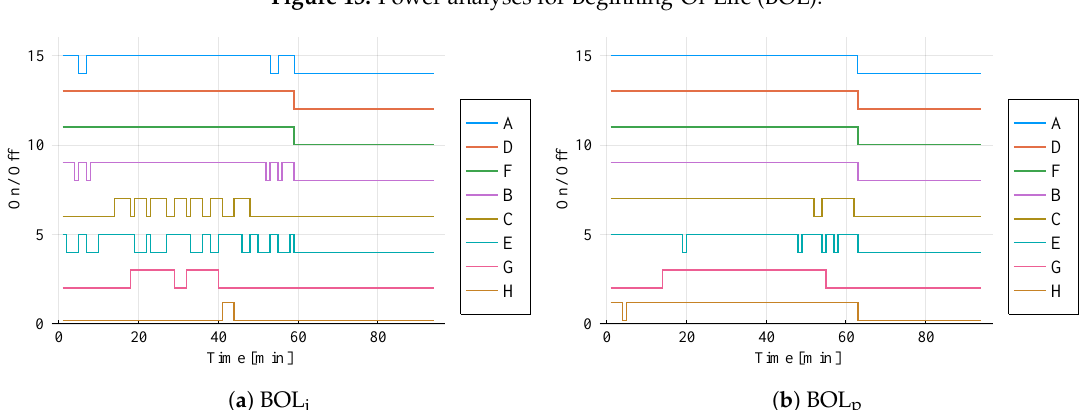
Figure 13. Power analyses for Beginning-Of-Life (BOL).